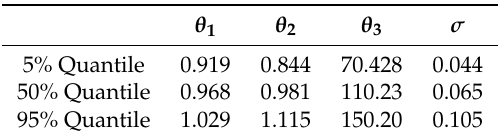
Table 2. Quantiles of posterior samples for all parameters. The x% quantile for a parameter is defined as the level that corresponds to x% of the values of the parameter over all TMCMC samples, arranged in increasing order, to fall below this level.